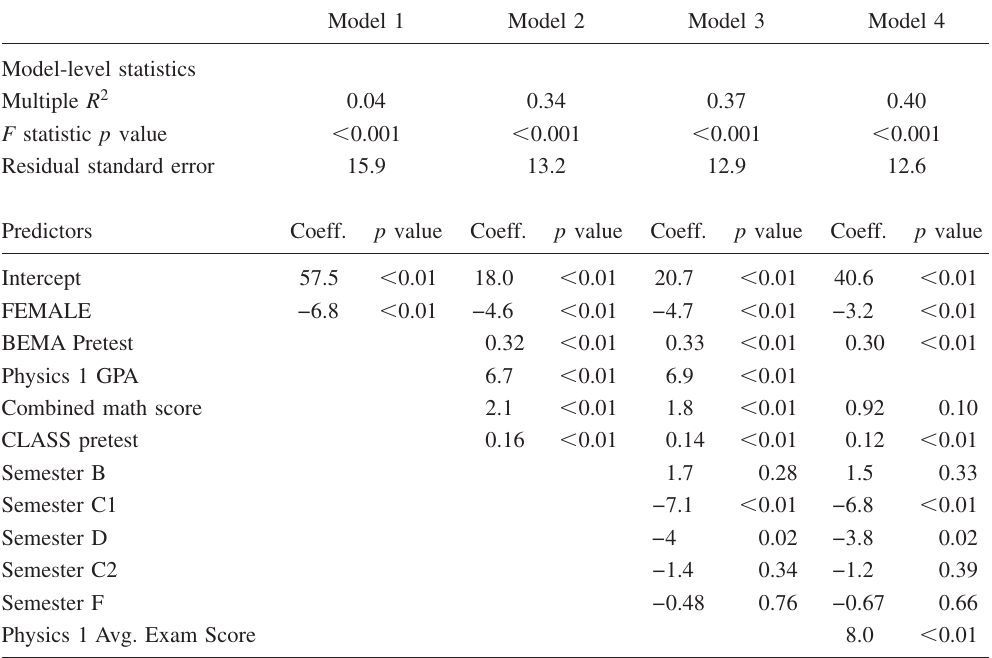
TABLE XII. Coefficient estimates and multiple-regression model statistics for each multiple-regression model. The S 2 sample was used for this regression